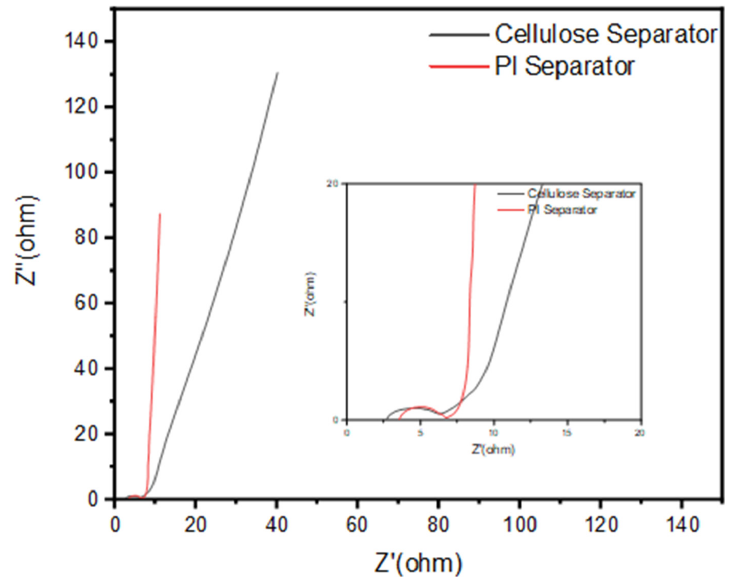
Figure 11. Nyquist impedance plots of the capacitor using BI-PI separator and cellulose separator, respectively, over frequency range of 100 kHz to 10 mHz and applied potential of 0 V. The inset shows a magnified view of the high-frequency region of the impedance spectra.